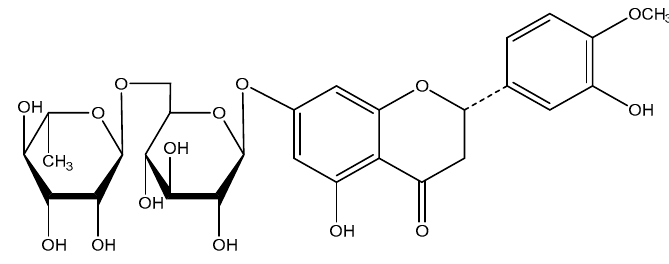
Figure 1. Chemical structure of hesperidin, figure adapted from [5].